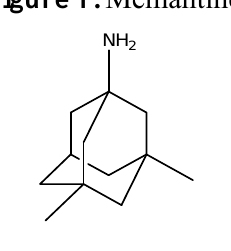
Figure 1. Memantine.